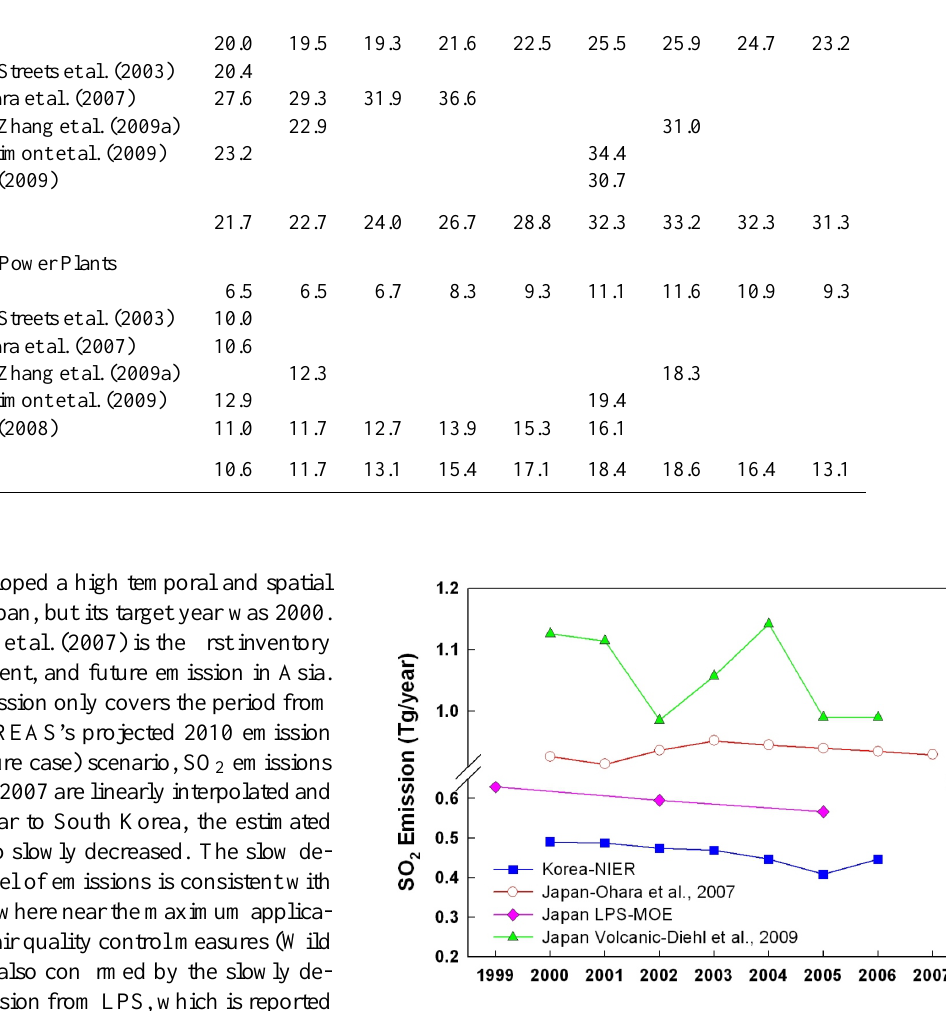
Fig. 4. Trends of SO 2 emission in Japan and South